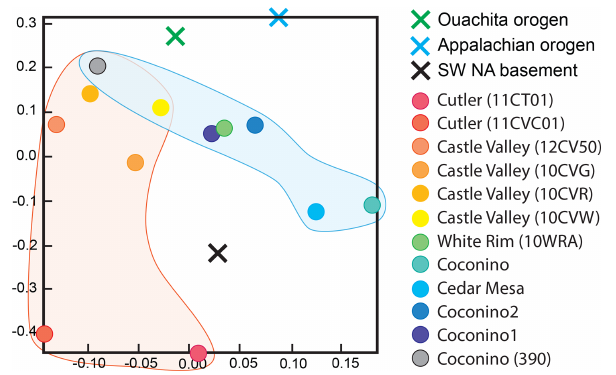
Figure 11. MDS plot comparing age distributions of Permian strata of the Colorado Plateau with each other and with potential source regions including the Appalachian orogen, Ouachita orogen, and basement rocks of southwestern North America. Data sources are described in Figs. 3 and 4. The data support the interpretation of Lawton et al. (2015) that the Coconino, Cedar Mesa, and White Rim sandstones (cool shades) belong to a regional blanket of eolian strata that was derived largely from the Appalachian and/or Oua- chita orogen, where strata of the Castle Valley and Cutler forma- tions (warm shades) include greater proportions of detritus derived from local basement